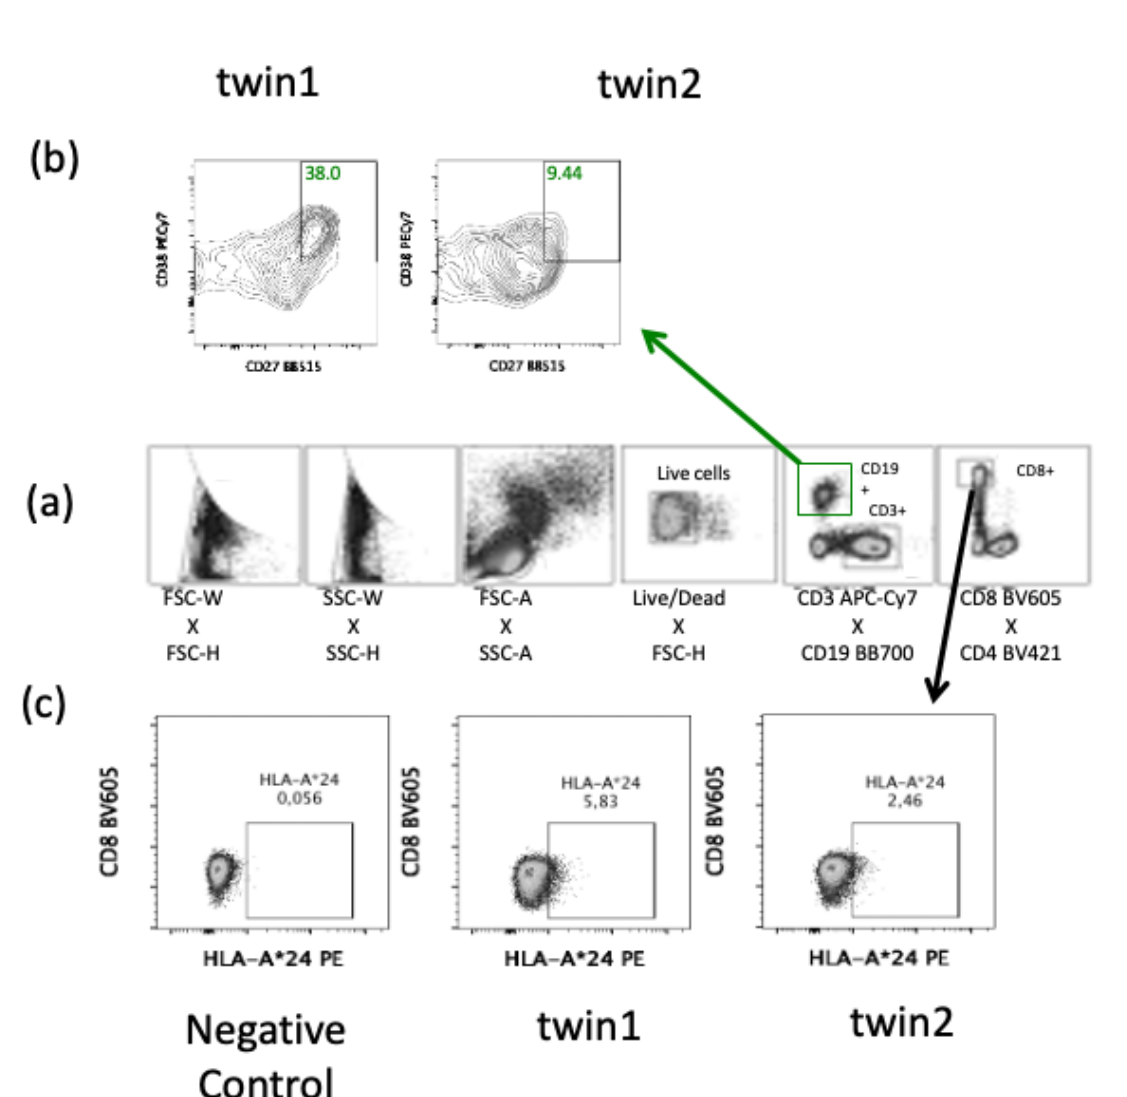
Figure 2. Gate strategy to set B and T lymphocytes by flow cytometry. ( a ) Gate strategy to set B cells (CD19+) (green) as well as T cells (CD3+) (black) from peripheral blood mononuclear cells. ( b ) Percentage of twins’ memory B cells subset (CD19+CD27+CD38+) activated after spike glycoprotein activation at 30 days after the second dose of COVID-19 vaccine (120 days). ( c ) Twins’ CD8+ T cells expressing the supertype HLA class I A*24 by immunophenotyping from peripheral mononuclear cells at the day 120 into the follow up (30 days after second dose of COVID-19 vaccine) and using a negative control (HLA-A*02).